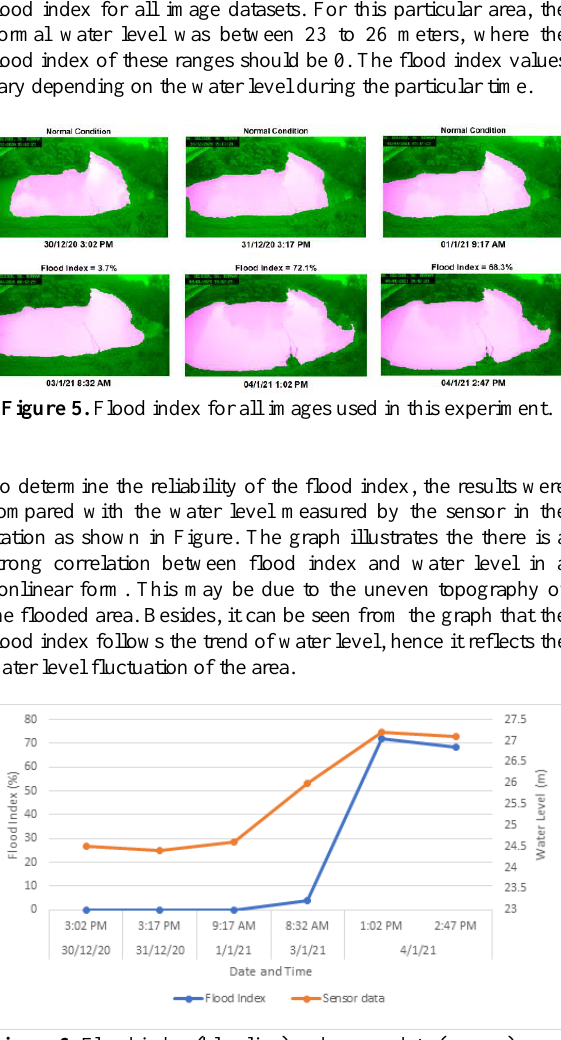
Figure 6 . Flood index (blue line) and sensor data (orange) were plotted against the local time of the images